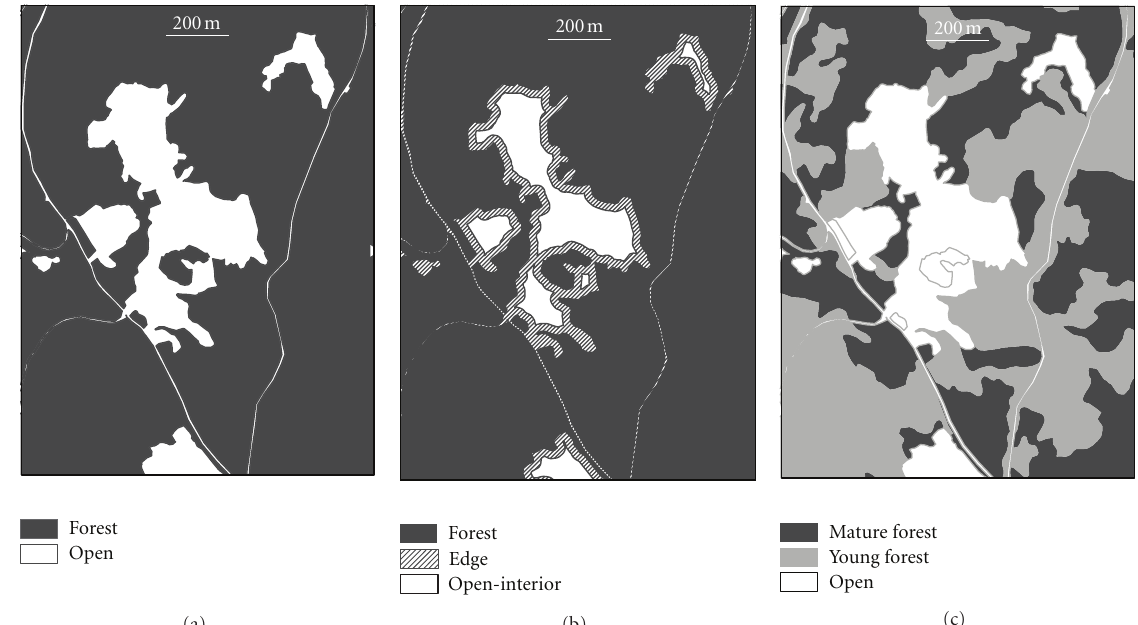
Figure 3: Three habitat resistance scenarios, applied to a selected part of the Montmorency Forest, Quebec, Canada.